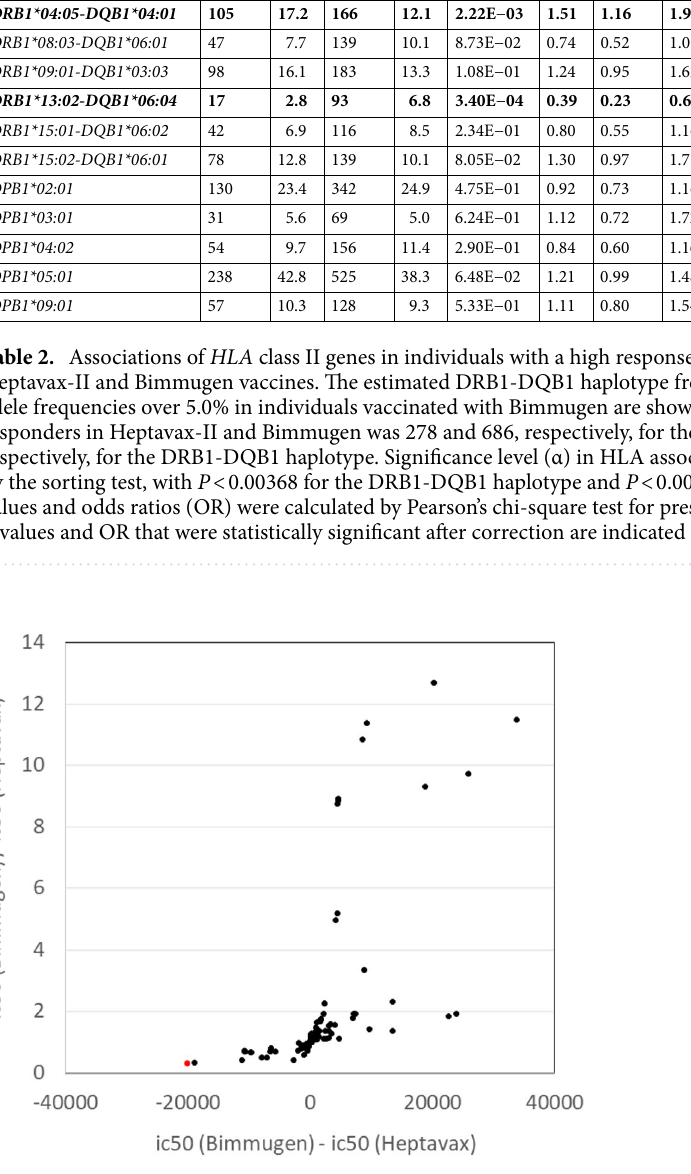
Figure 3. Search for vaccine-derived peptides that are unstable with Heptavax-II and stable with Bimmugen for DRB1*13:02 binding. The horizontal axis plots differences in IC 50 values of the peptides from Bimmugen and Heptavax-II, and the vertical axis plots the ratio of IC 50 . The red dot indicates the most promising candidate for instability among Heptavax-II-derived peptides and stability among Bimmugen-derived